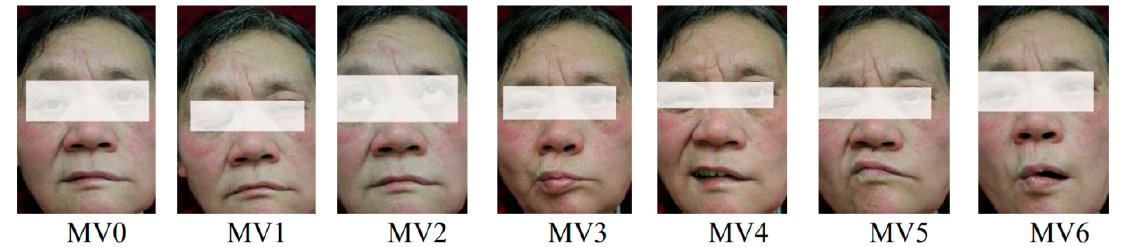
Figure 2. Facial images of patients with paralysis during the seven movement types.